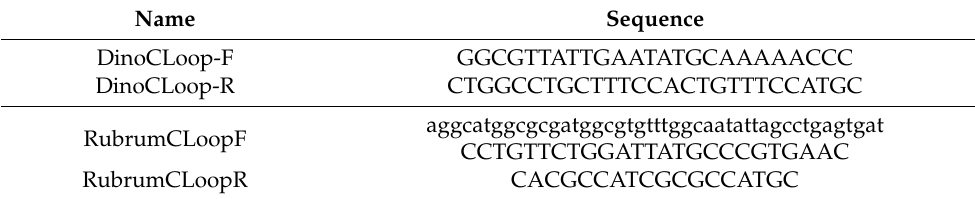
Table 5. Sequences of the primers used in mutant’s